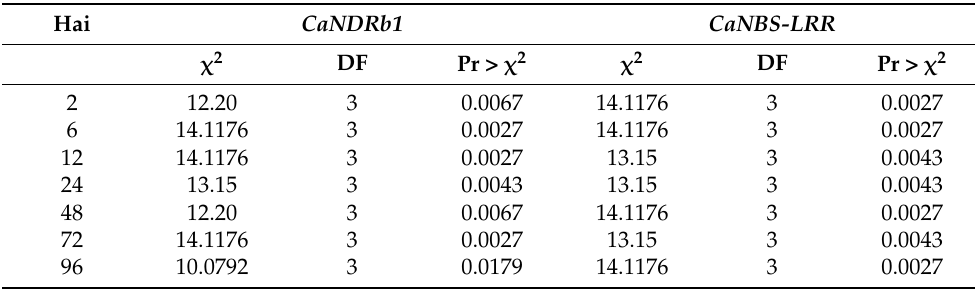
Table 3. Values obtained from the Kruskal–Wallis test comparing the relative expression of CLR recognition genes in